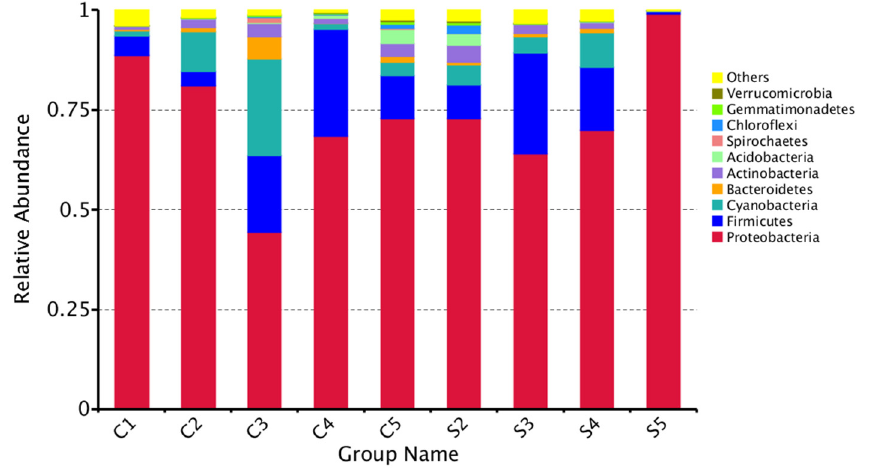
Figure 4. The relative abundance of the top 10 phyla of the control and treatment groups at the same time points.